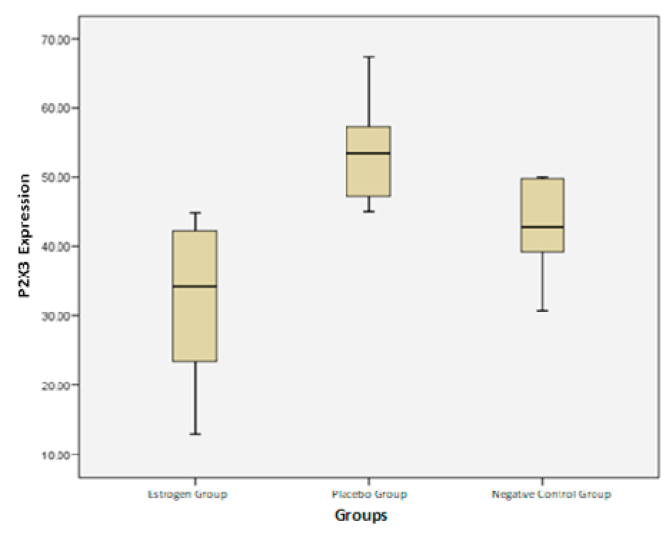
Graph boxplot comparison of P2X3 expressions for each group.